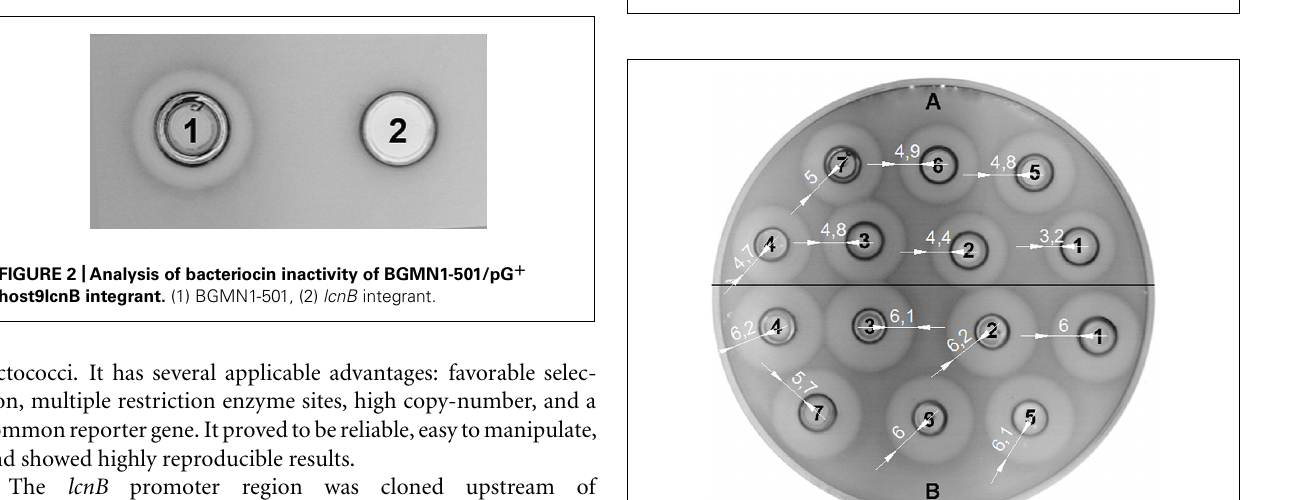
FIGURE 3 | Pulsed-field gel electrophoresis ( Sma I macroresriction pattern) of PrtP – (A) and LcnB – (B) mutants of BGMN1-501. (1) BGMN1-501; (2) BGMN1-501 carrying adequate free pG + host with fragment for homologous recombination (growth at 28 ◦ C); (3) mutants of BGMN1-501; L, phage λ DNA concatemers.Wide arrows indicate free pG + host with a fragment for homologous recombination, sharp arrows indicate the appearance of new Sma I fragments in generated mutants after insertion of pG + host vectors (pG + host introduces additional Sma I site).